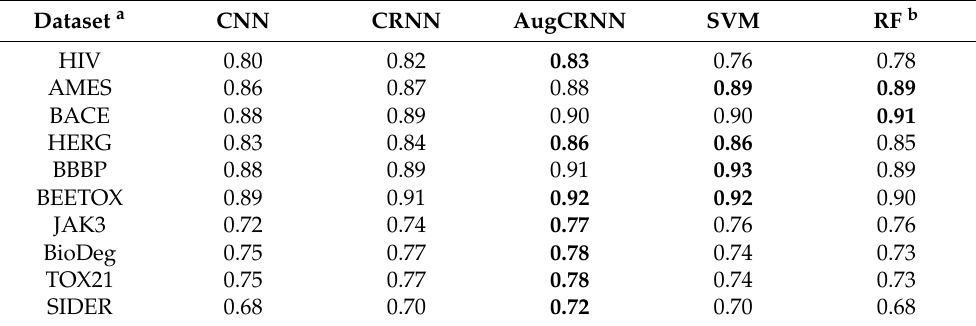
Table 3. The area under the receiver characteristic curve (ROC-AUC) for classification datasets of drug